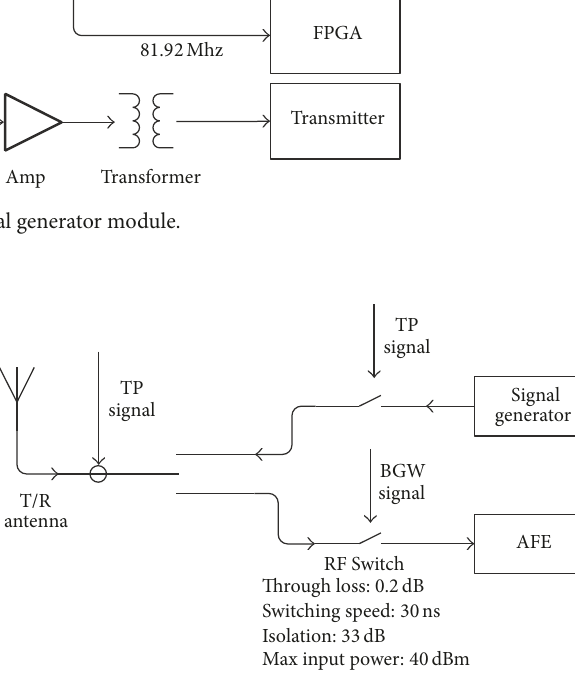
Figure 5: T/R switch